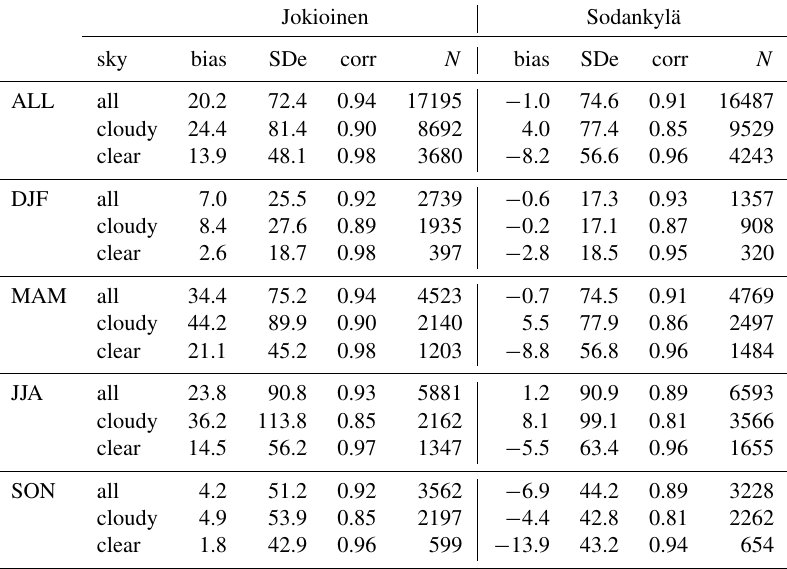
Table 3. HIRLAM forecast versus observed SWDS (unit Wm − 2 ) at Jokioinen and Sodankylä for 2006–2016 classified according to CSI8. Bias, standard deviation of the error (SDe) and correlation (corr) are shown for all months (ALL), December–January–February (DJF) and the other three seasons (JJA, SON, MAM). N is the number of cases.